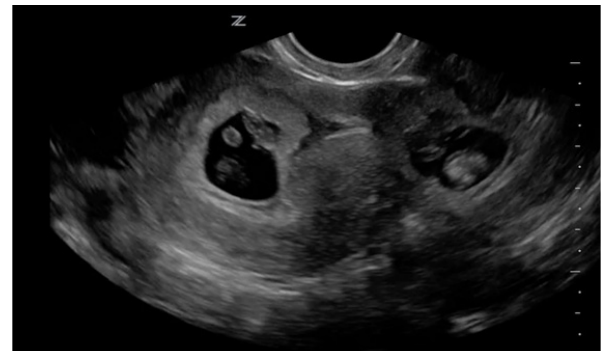
Figure 1. Longitudinal transvaginal ultrasound demonstrating intrauterine pregnancy on the left and the mirror-image artifact on the right of the image.